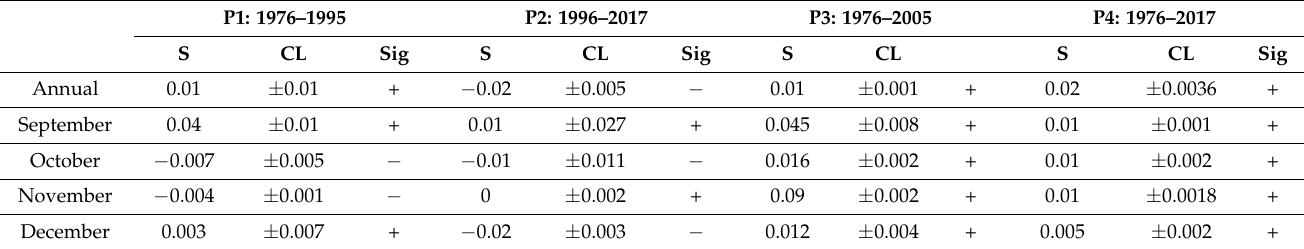
Table 3. Trend analysis using the ITA method for upstream of the Merguellil watershed (Skhira station), m 3